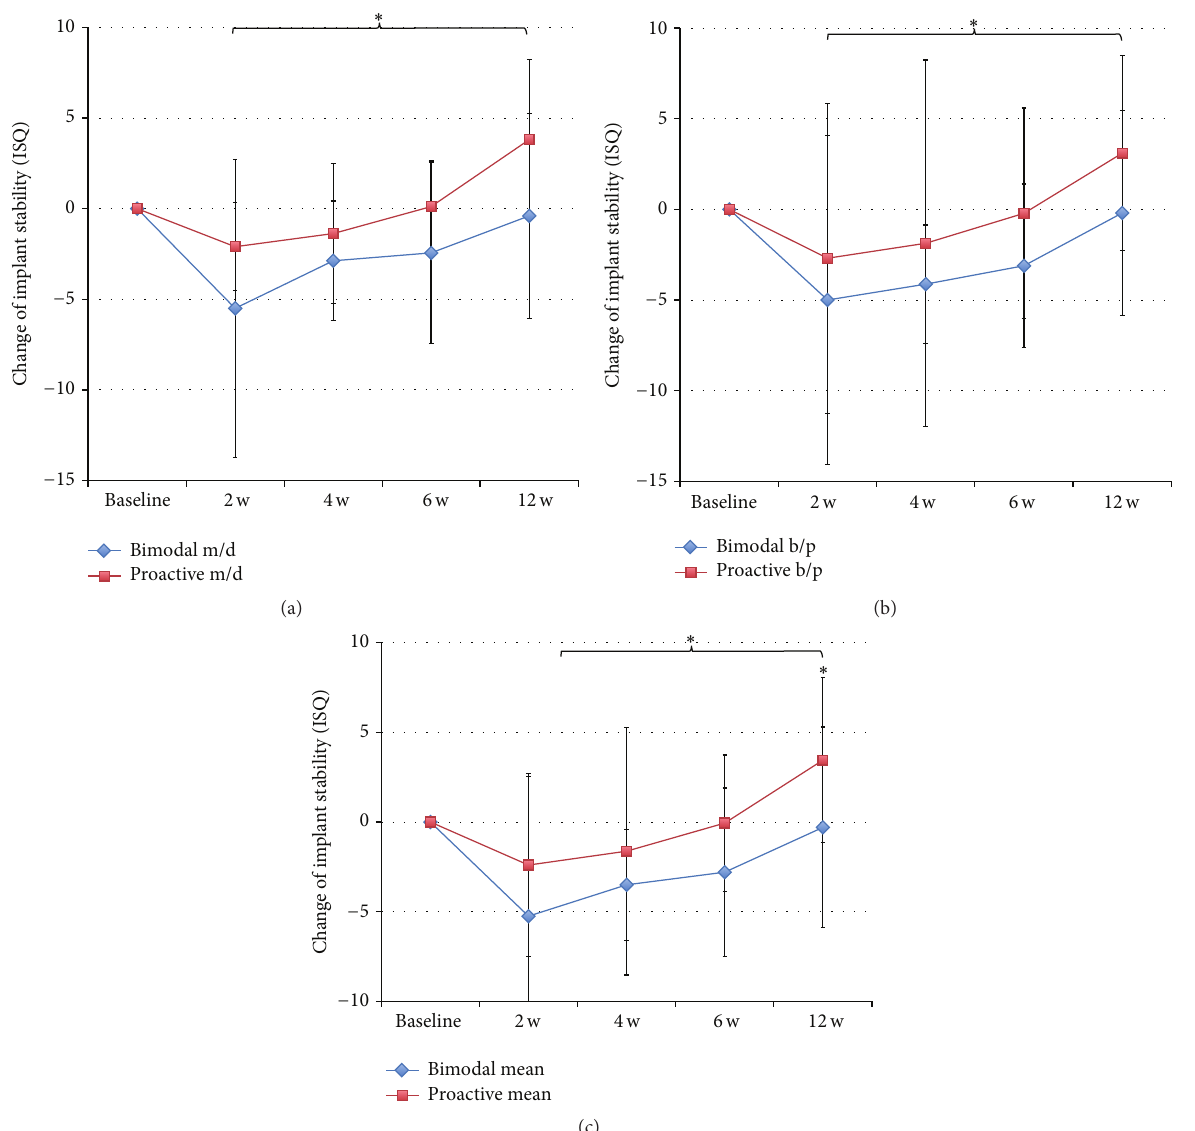
Figure 4: (a) Showing change in ISQ values with time compared to baseline for bimodal and proactive implants in MD direction. ∗ 𝑝 ≤ 0.05 . (b) Showing change in ISQ values with time compared to baseline in BP direction. ∗ 𝑝 ≤ 0.05 . (c) Showing change in ISQ values with time compared to baseline for mean values. ∗ 𝑝 ≤ 0.05